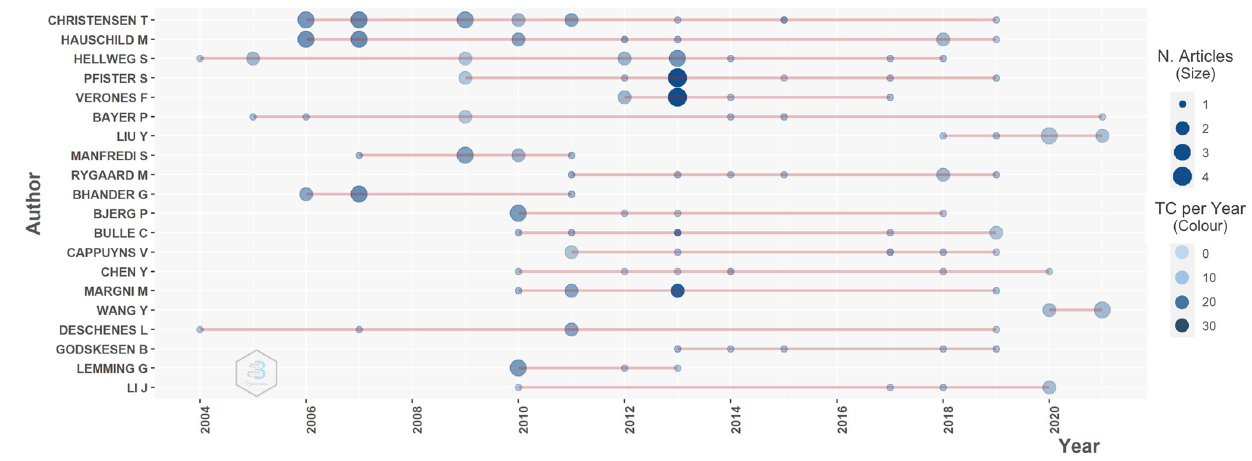
Figure 4. Number (N) of articles and the main authors’ annual Total Citations (TC). Documents: 306 documents only from Scopus and 158 from WoS and 316 from both databases.